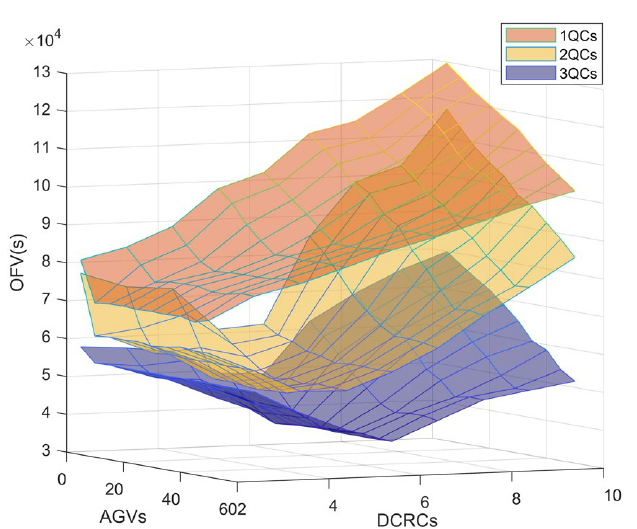
Figure 13. OFV(s). Figure 13. OFV(s).